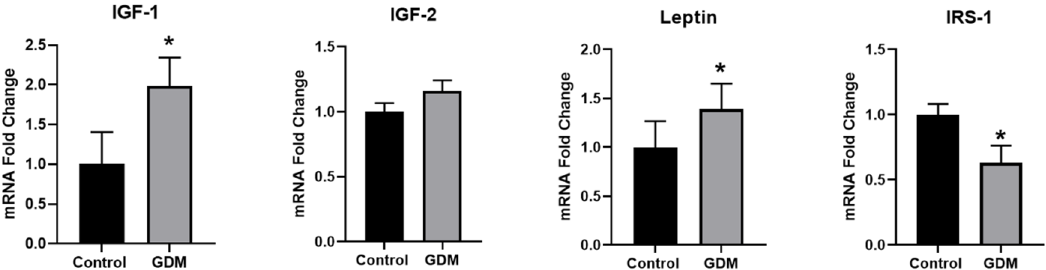
Figure 1. Changes in mRNA levels of genes related to insulin signaling in trophoblasts exposed to control and GDM conditions. Primary human trophoblasts were cultured in standard conditions or medium containing 25-mmol / L glucose and 10 − 7 -mol / L insulin for 72 h, and real-time PCR was used to assess gene expression. Values are expressed as mean ± SD of three independent experiments. * p < 0.05 vs. control.